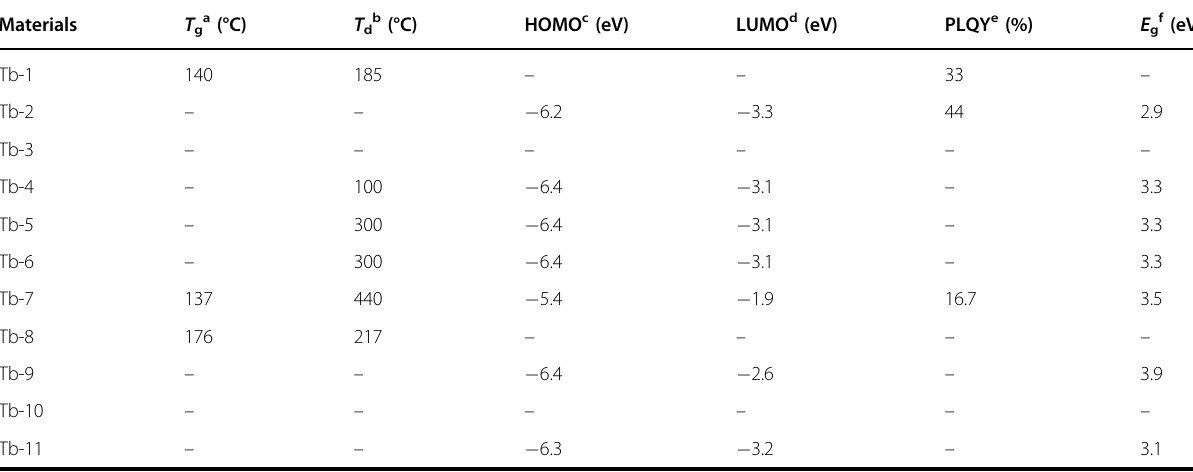
Table 1 The physicochemical properties of the representative terbium complexes